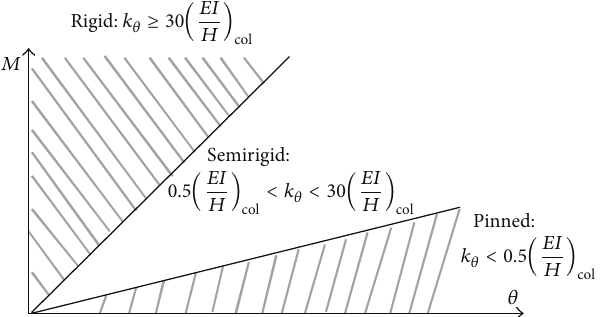
Figure 1: Eurocode 3 [5] column base rotational stiffness bound-